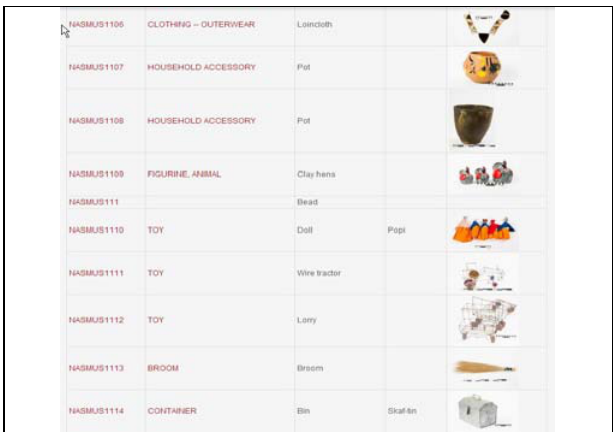
Figure 6. Object listing of some items captured on SAHRIS by museum